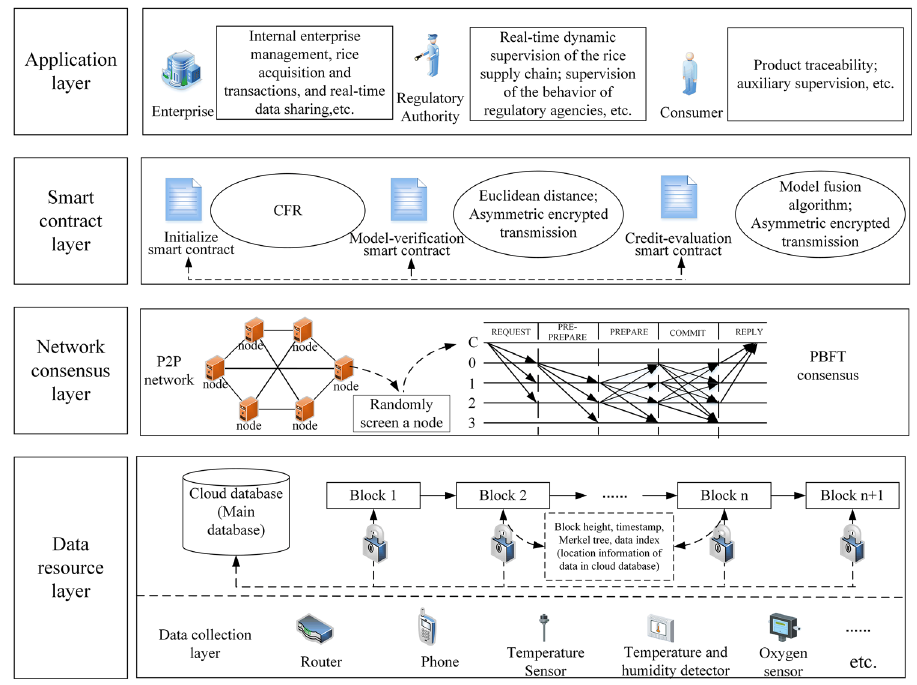
Figure 7. Prototype system architecture